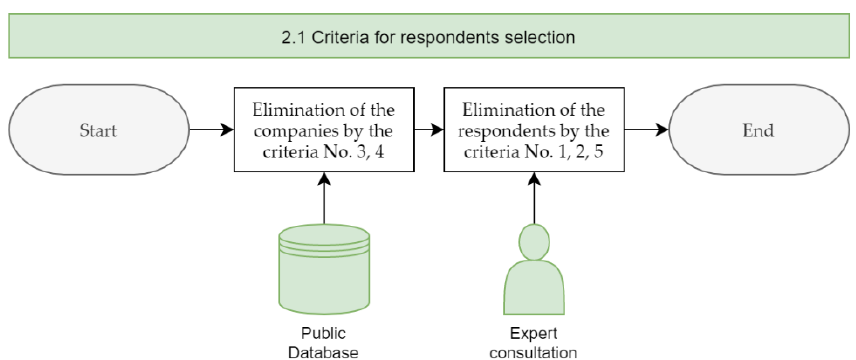
Figure 3. Process of elimination of inappropriate companies and respondents.